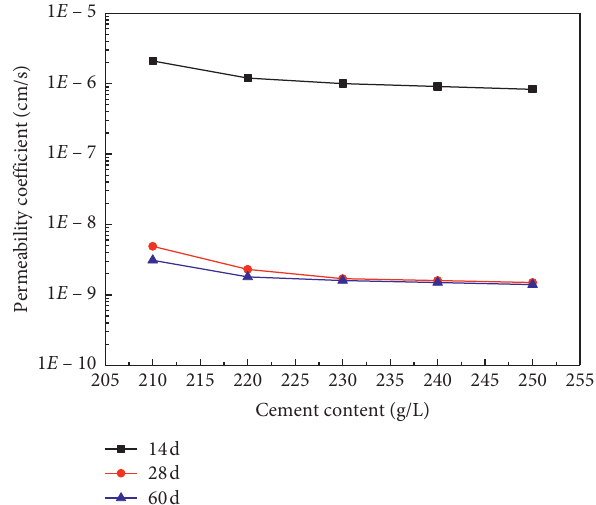
Figure 4: Curve of influence of different cement contents on permeability coefficient of samples.